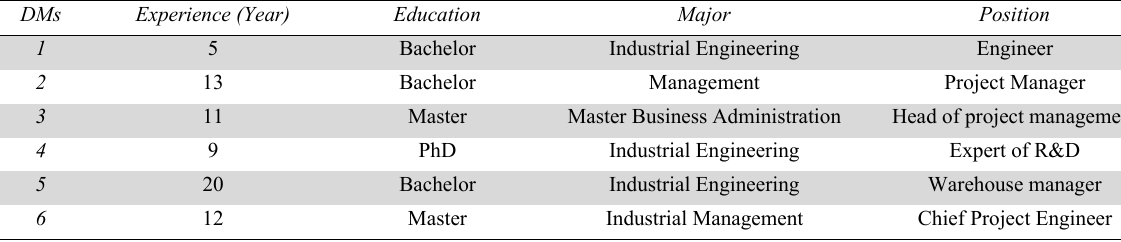
Information of decision makers (DMs) who participate on questionnaires